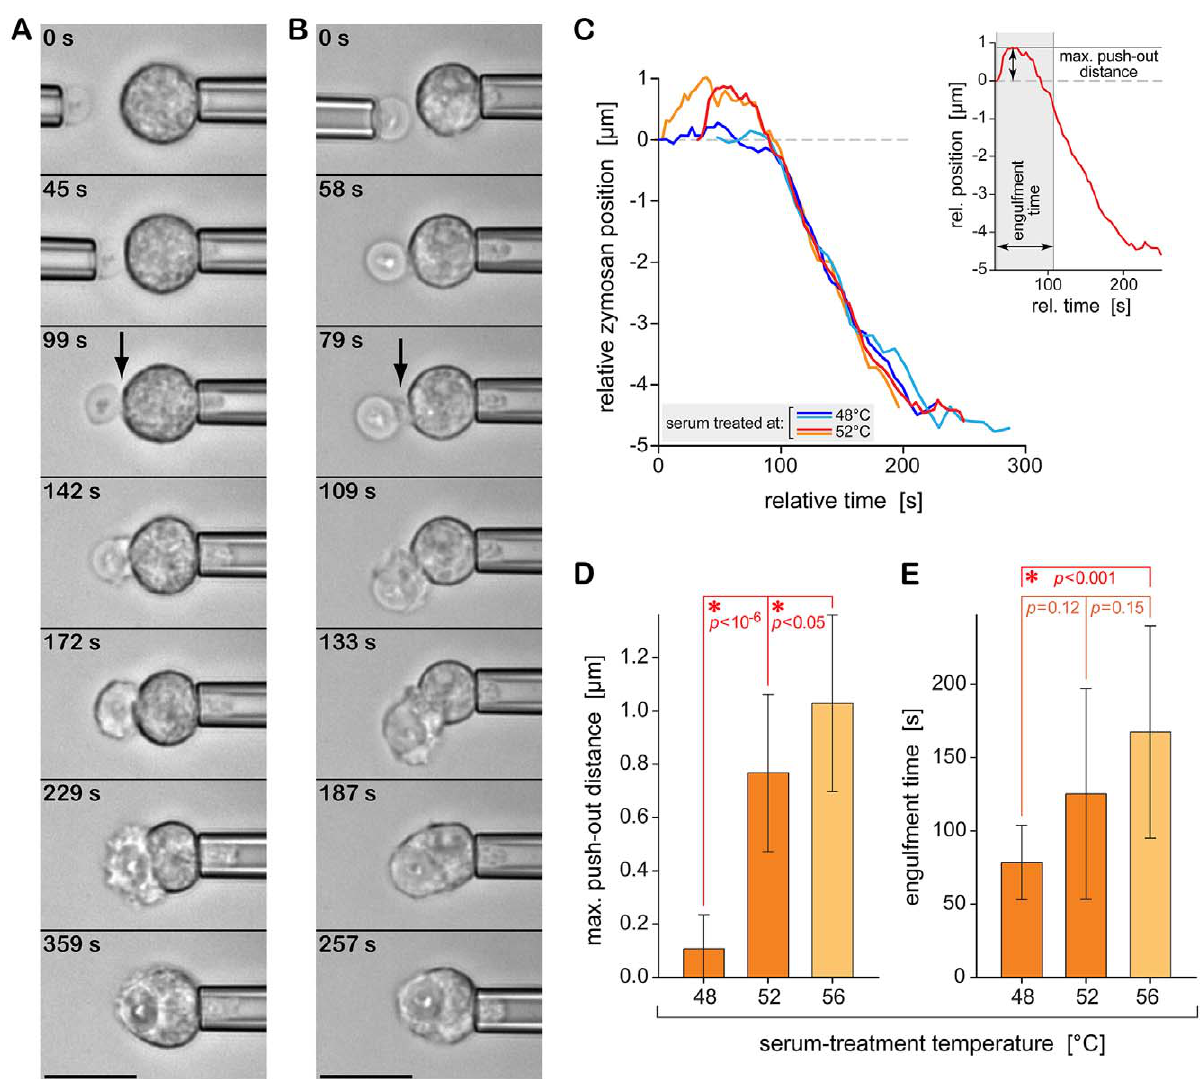
Figure 4. Single-cell/single-target experiment to quantify the time course of phagocytosis of initially quiescent immune cells. ( A ) Using dual-micropipette manipulation, a zymosan particle is ‘‘handed over’’ to an initially passive neutrophil. Subsequent videomicrographs illustrate the ensuing phagocytosis (relative times are included). An arrow marks the small pseudopodial ‘‘pedestal’’ that initially ‘‘pushes’’ the particle outwards. In this experiment, the zymosan particle was pre-opsonized with 48 u C-treated serum and then washed. The experiment buffer was supplemented with 52 u C-treated serum. ( B ) Same type of experiment as in (A), but here the particle was opsonized in the experiment buffer containing 52 u C-treated serum. ( C ) Quantitative comparison of typical time-dependent positional traces of opsonized zymosan particles during single-cell phagocytosis by initially passive neutrophils. Two traces each are shown for zymosan opsonized with 48 u C- and 52 u C-treated serum, respectively. The individual time axes were aligned for maximum overlap during the inward movement of the particles. The inset illustrates our analysis in terms of the maximum push-out distance of the target particle and of the total engulfment time. ( D ) Average maximum push-out distances of zymosan from measurements such as illustrated in (C) for the two types of opsonized zymosan particles. ( E ) Average target engulfment times for the same experiments as analyzed in (D). Scale bars in (A) and (B) denote 10 m m. Also included in (D) and (E) are the results of previous measurements (shown in a lighter color) where zymosan had been opsonized in 56 u C-treated serum. Values in (D) and (E) are means 6